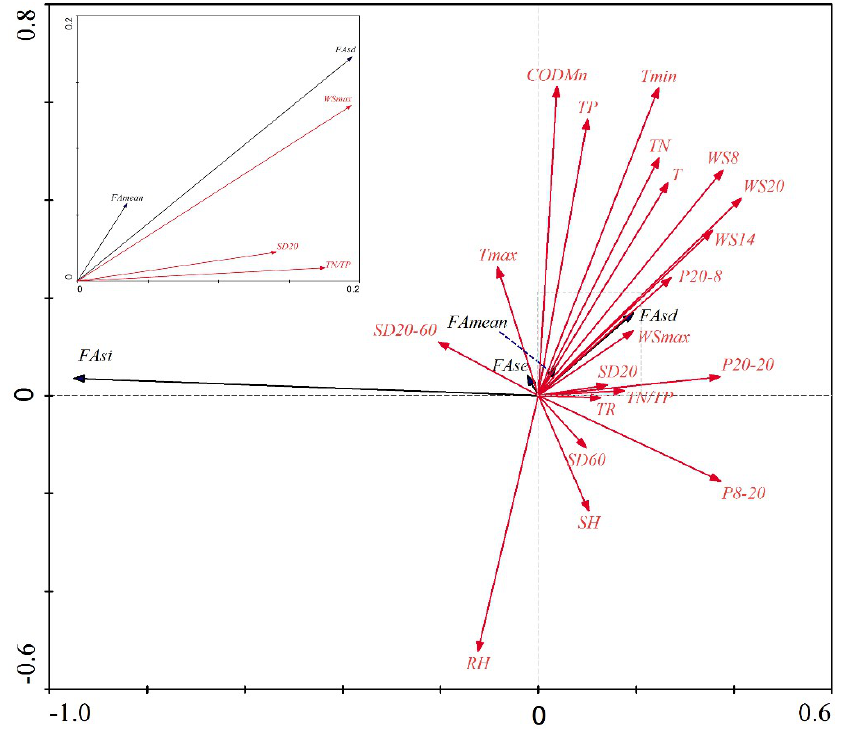
Figure 17. RDA ordination diagram of annual cyanobacteria bloom characteristics and environmental variables.